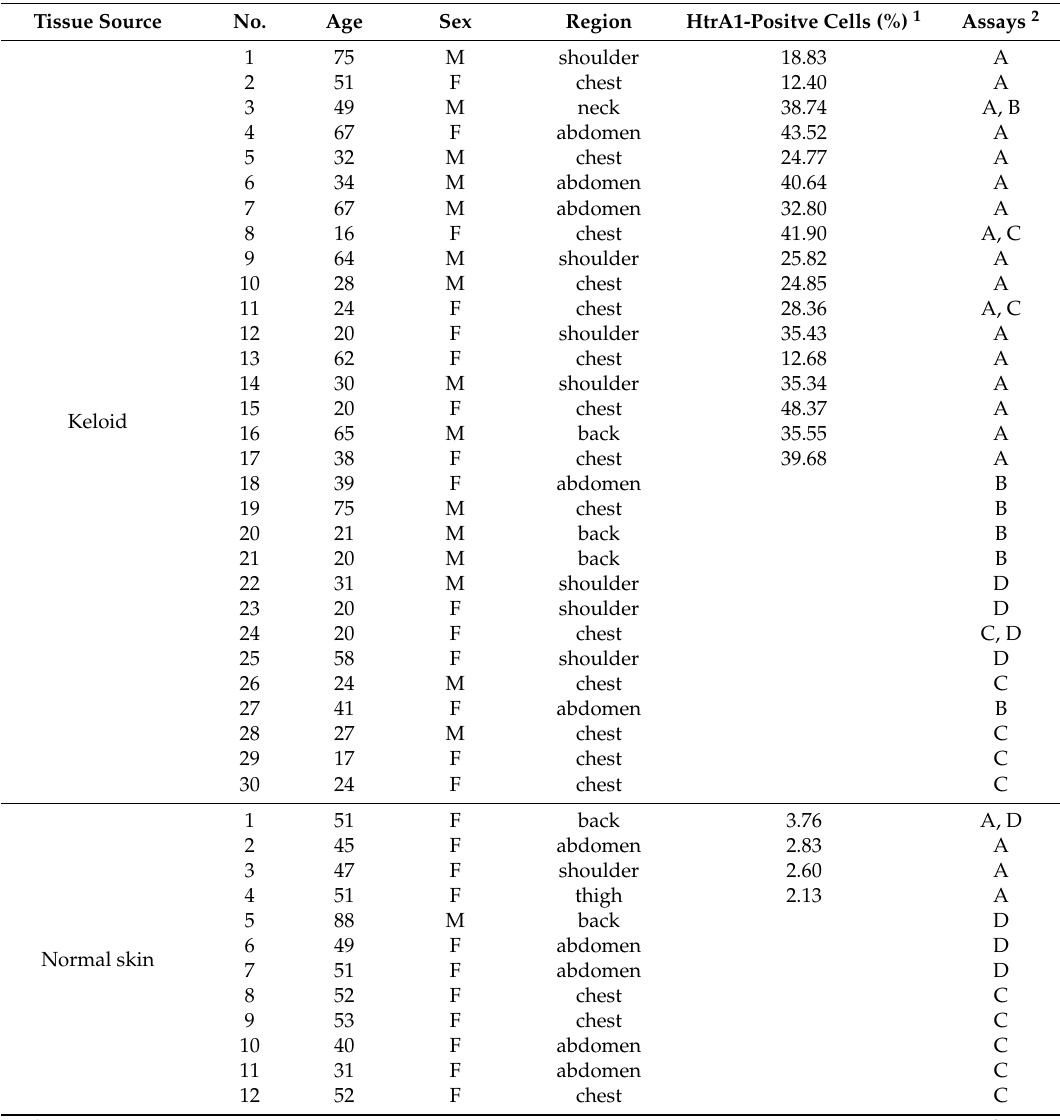
Table 1. Samples used in this